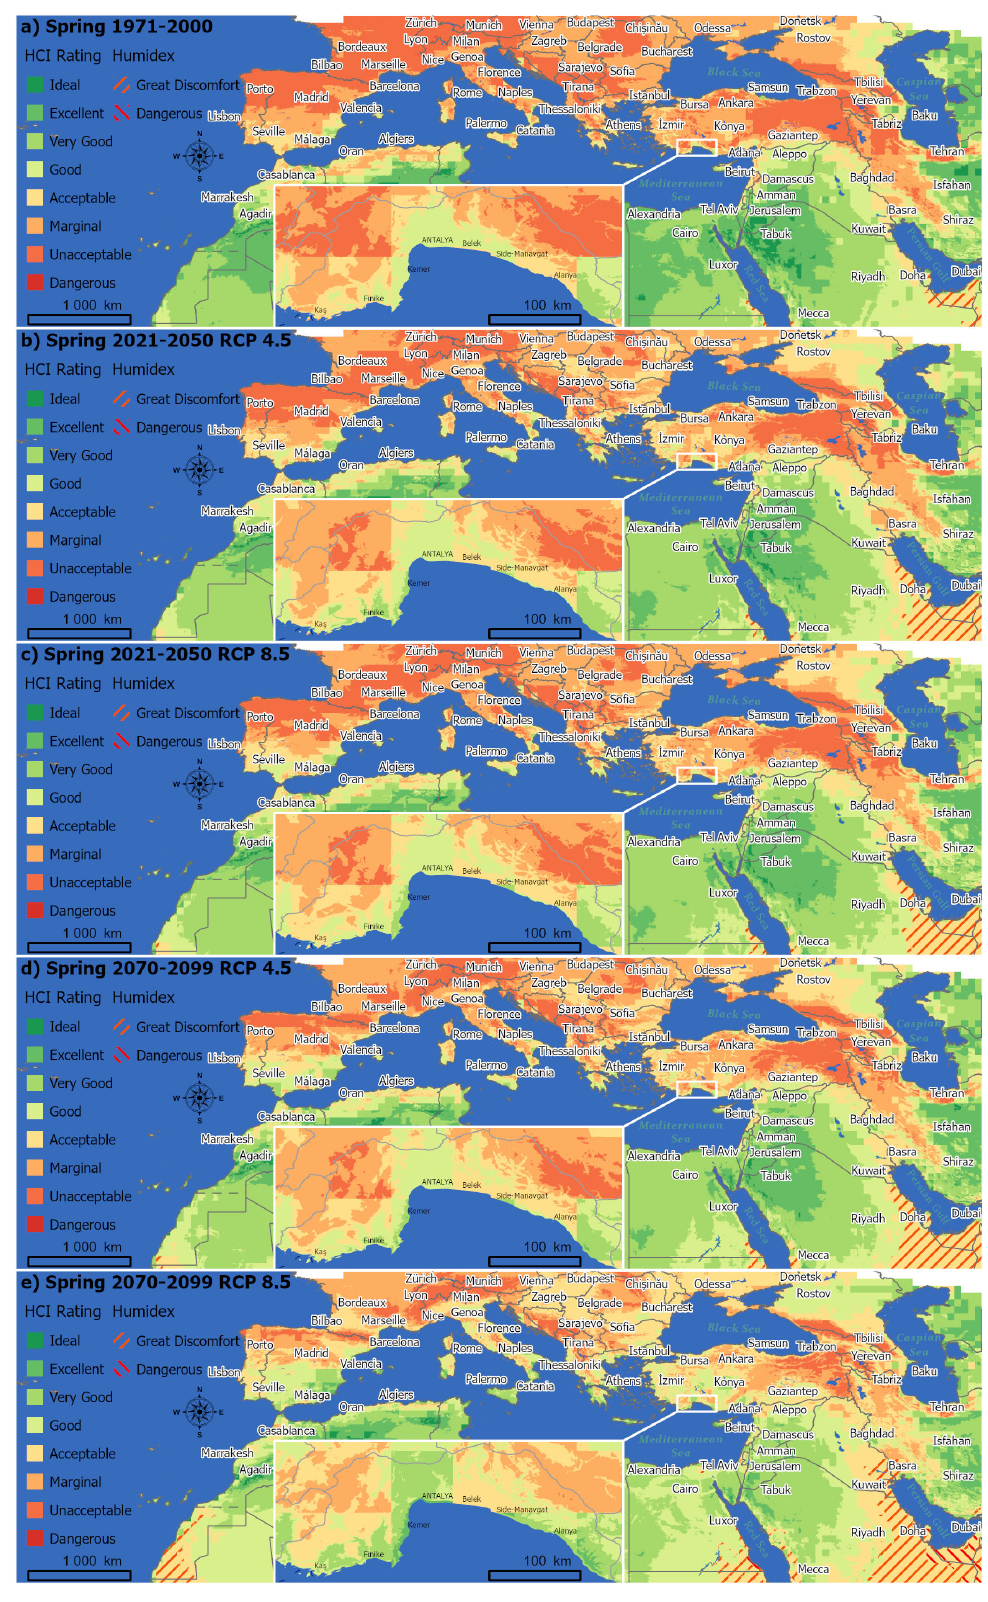
Figure 5. Spring season Holiday Climate Index (HCI) ratings and Humidex risks in the greater Mediterranean region for the projection periods ( a ) 1971–2000 ( b ) 2021–2050 (RCP 4.5) ( c ) 2021–2050 (RCP 8.5) ( d ) 2070–2099 (RCP 4.5) ( e ) 2070–2099 (RCP